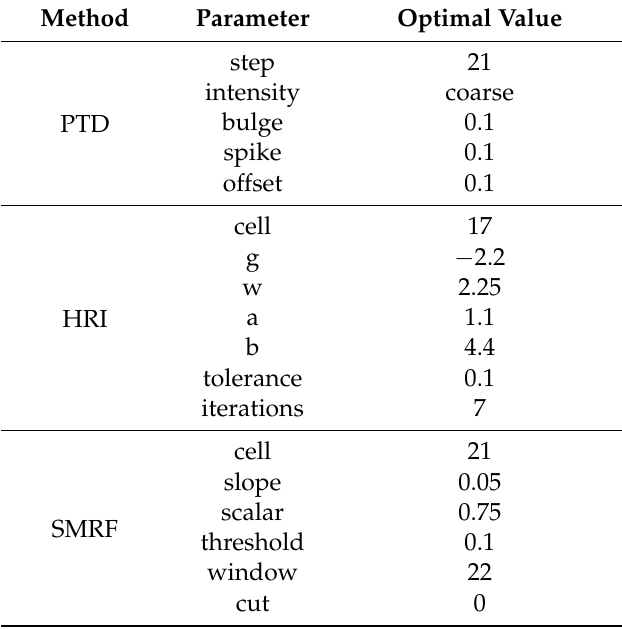
Table 6. Optimal parameters found for each ground-classification algorithm